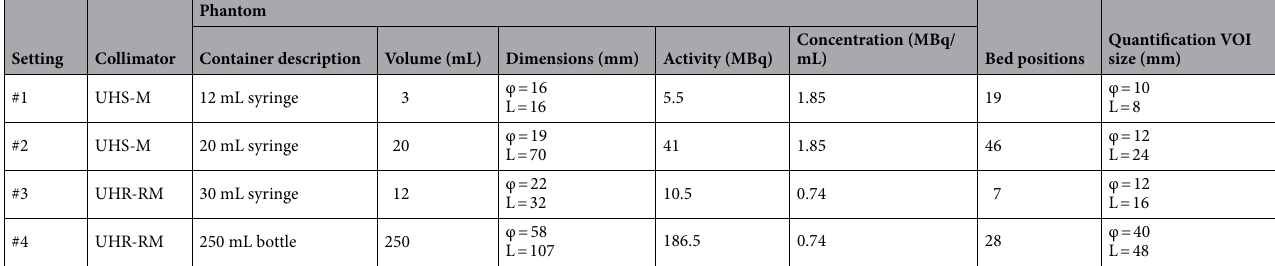
Table 1. Description of the geometry of the sources used for uniformity